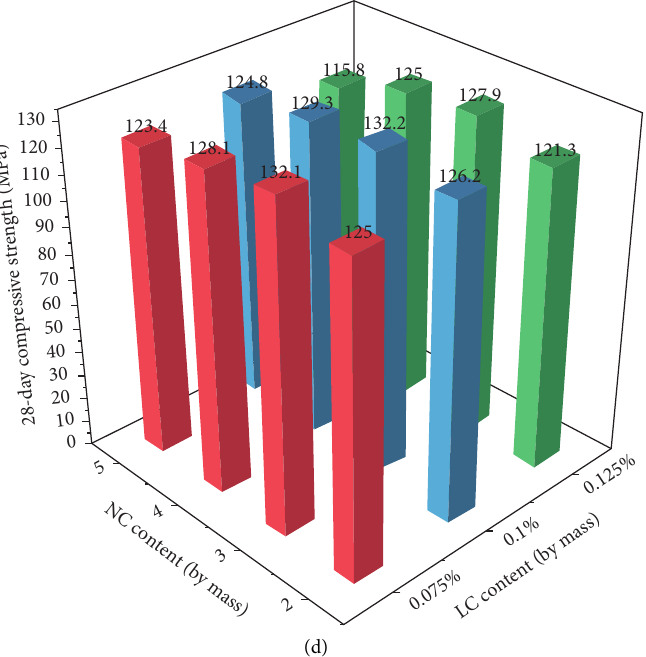
Figure 2: Effects of LC-NC combined additives on the UHPC compressive strength.